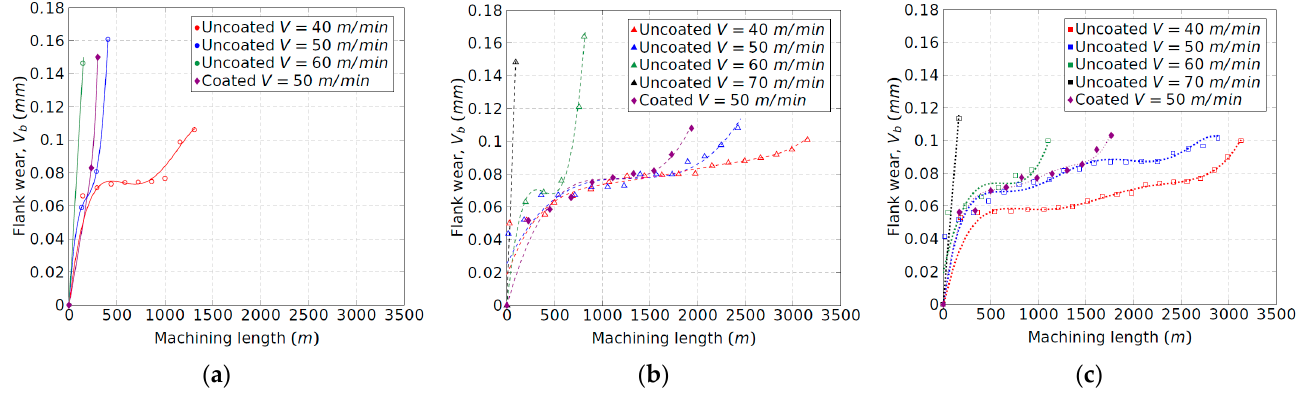
Figure 3. Tool wear evolution of the uncoated tool: ( a ) configuration 1; ( b ) configuration 2; and ( c ) configuration 3.